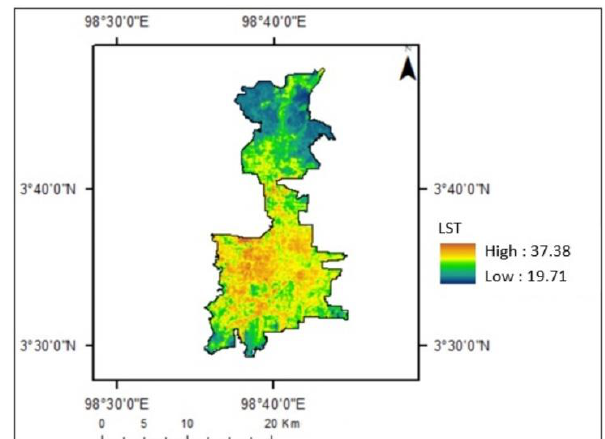
Figure 5. LST of Medan in 2019.